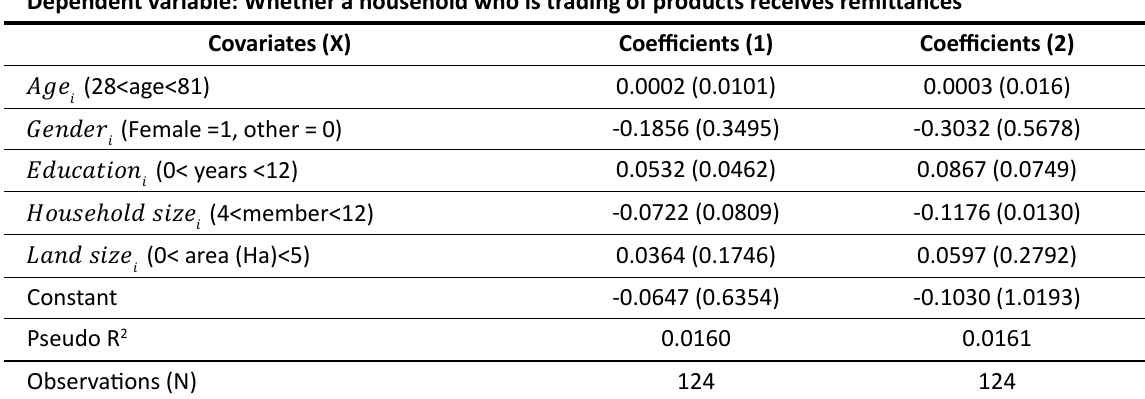
Table 4: Probit and Logit Estimation for Propensity Score